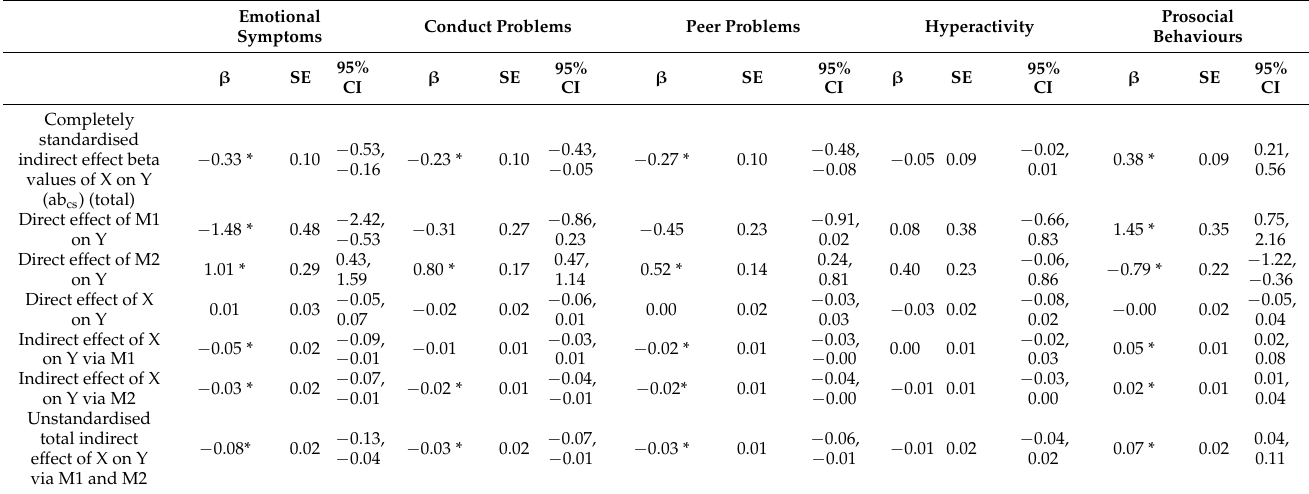
Table 6. Parallel mediation analysis examining indirect effects of child–dog attachment (X) on caregiver-reported child psychopathology (Strengths and Difficulties Questionnaire, SDQ) (Y), via